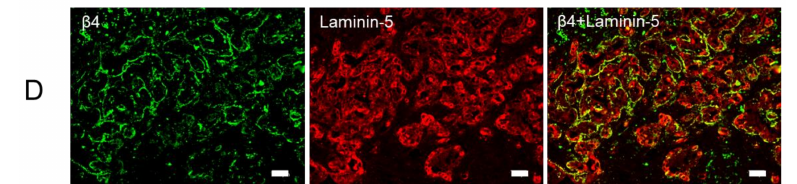
Figure 3. The relationship between β 4 or β 6 expression and laminin-5 or tenascin-C expression. Based on immunohistochemistry, the expression levels of β 6 and tenascin-C are higher in intraductal-growth (IG) or periductal-infiltrating (PI) type intrahepatic cholangiocarcinomas than in the mass-forming (MF) type ( A ). β 4 and laminin-5 expression levels are higher in non-peripheral central localization type than in the peripheral localization type ( B ). Based on immunofluorescence staining, β 6 is located in the basal lamina, cell membrane, and cytoplasm ( C , green). The intense expression of tenascin-C is shown in the cytoplasm of the tumor cells ( C , red). The similar localization of β 6 and tenascin-C is shown in intrahepatic cholangiocarcinoma. The tumor cells are confirmed by hematoxylin and eosin staining ( C ). Based on double immunofluorescence staining, the expression of β 4 is located in the basal lamina, cell membrane, and cytoplasm ( D , green). The dense expression of laminin-5 is shown in the cytoplasm of the tumor cells ( D , red). In the merged images, there is coincident expression, but a different intracellular localization of β 4 and laminin-5 are observed in intrahepatic cholangiocarcinoma ( D , yellow). Scale bar, 50 µ m.